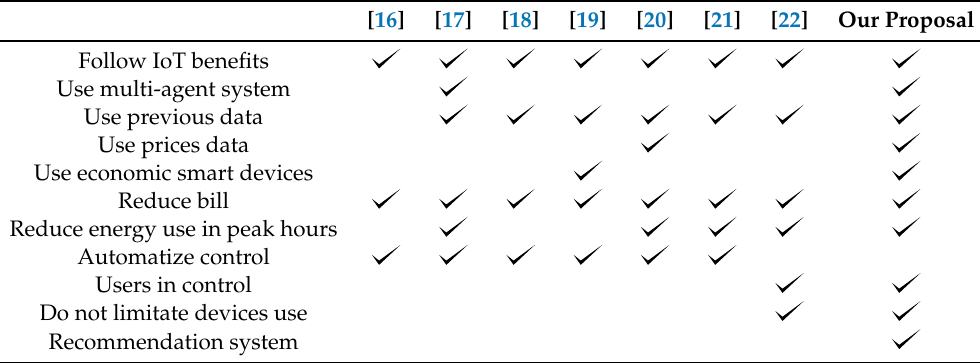
Table 1. Comparison between the proposal and previous works.